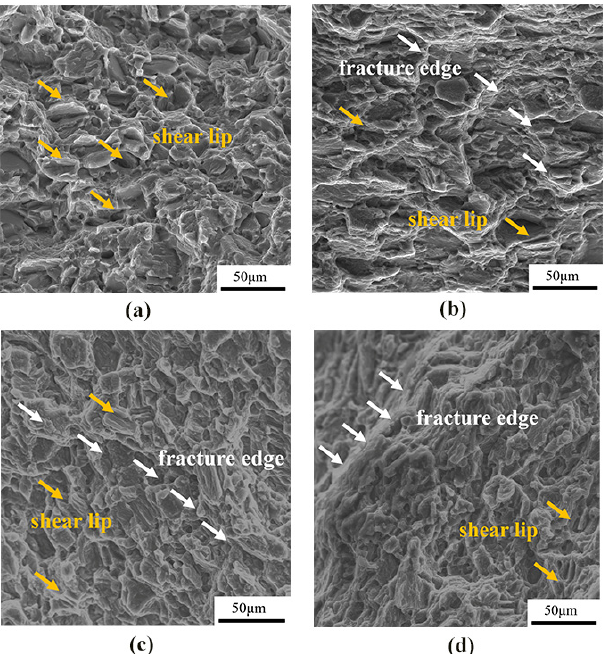
Figure 6. Fracture morphology of WE43 magnesium alloy under tension at room temperature in different states: ( a ) as-cast, ( b ) cold-rolled, ( c ) warm-rolled, and ( d ) hot-rolled.